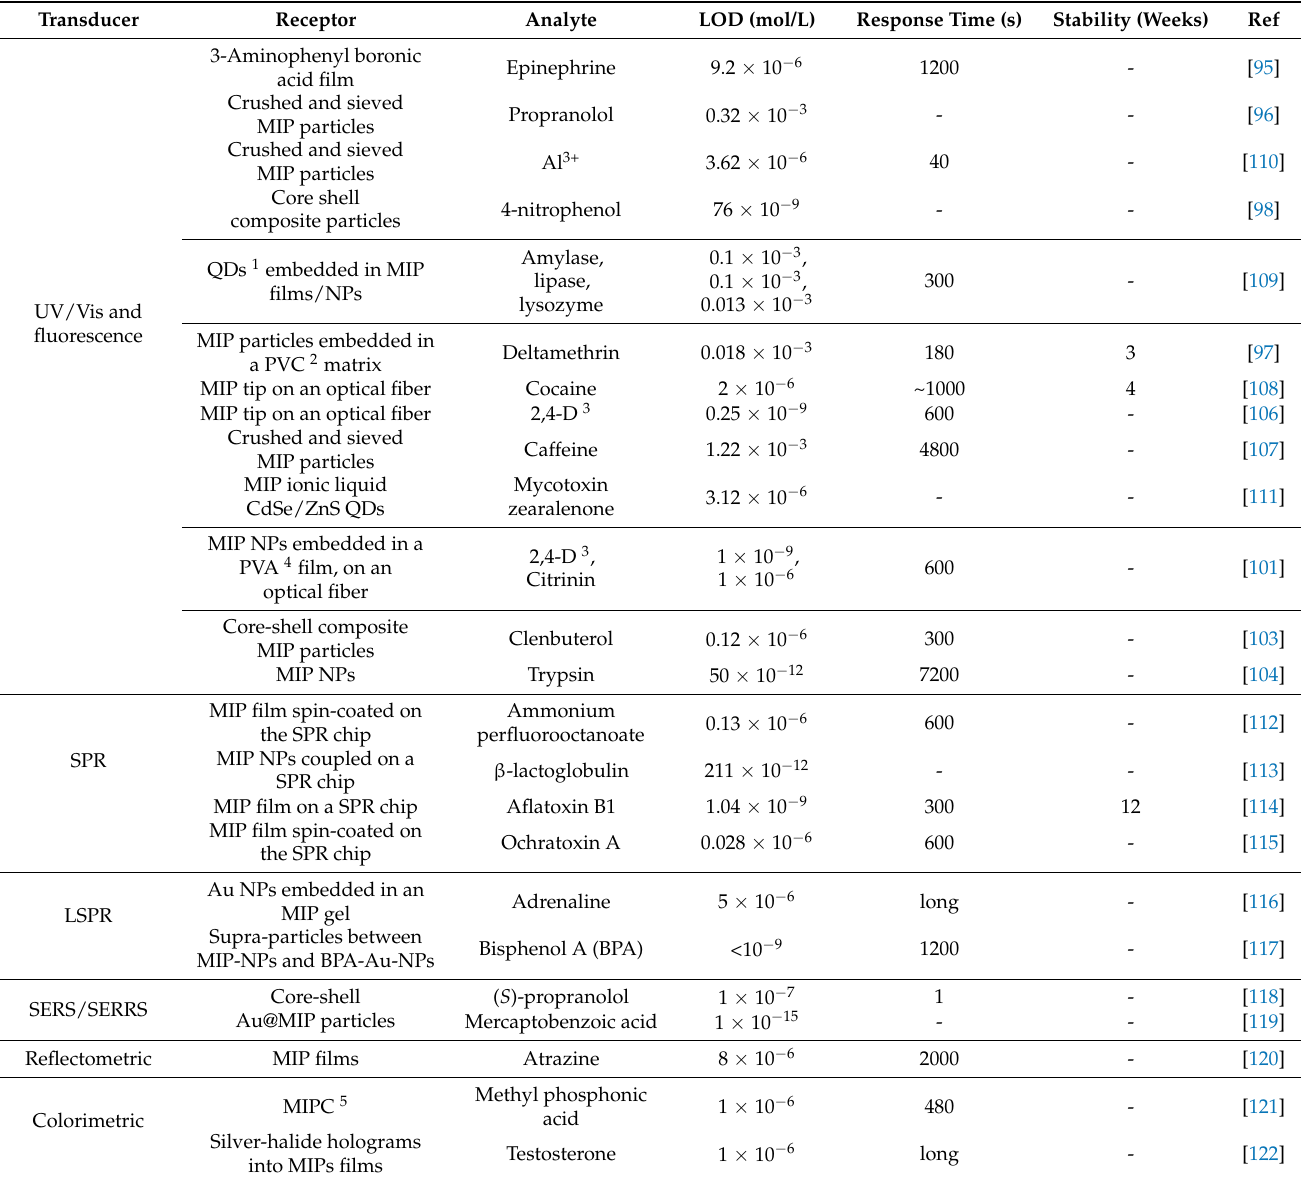
1 QDs: quantum dots; 2 PVC: polyvinyl chloride; 3 2,4-D: 2,4-dichlorophenoxyacetic acid; 4 PVA: polyvinyl alcohol; 5 MIPC: molecularly imprinted photonic